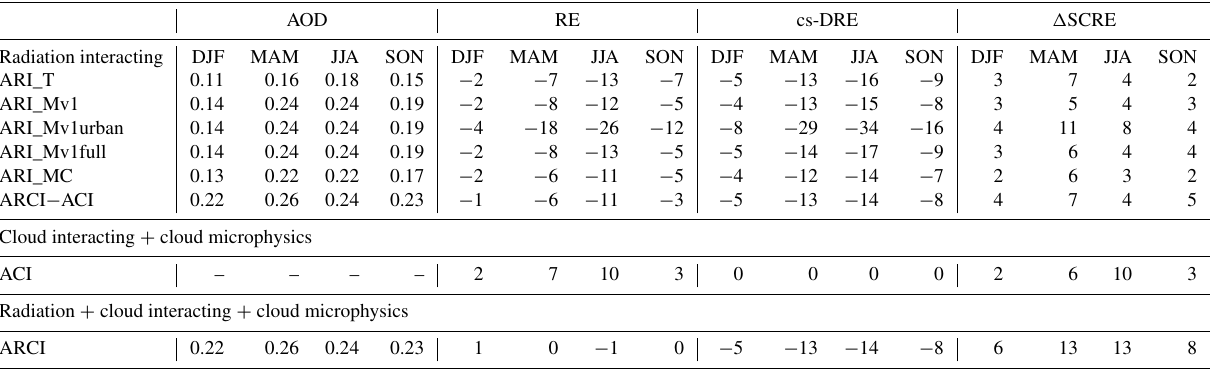
Table 2. Domain averages for each season regarding aerosol optical depth at 550nm (AOD 550 ), Radiative effect (RE), clear-sky direct radiative effect (cs-DRE) and change in shortwave cloud effect at the surface ( (cid:49) SCRE) all calculated as differences from control CON, for all experiments. In the first column the aerosol effect that is being implemented is stated above each group of simulations. For simulation ARCI all the above quantities are also calculated against ACI (e.g. ARCI–ACI) in order to assess the implementation of aerosol–radiation interactions in the Thompson aerosol–cloud interacting cloud